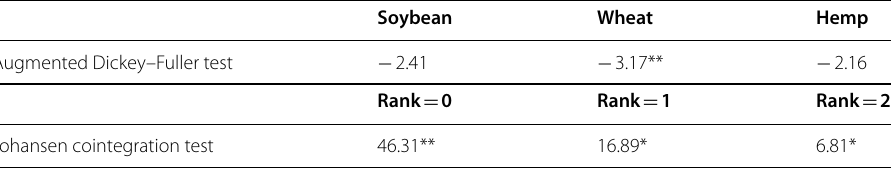
A single asterisk indicate significance at a 10% level. A double asterisk indicate significance at a 5%